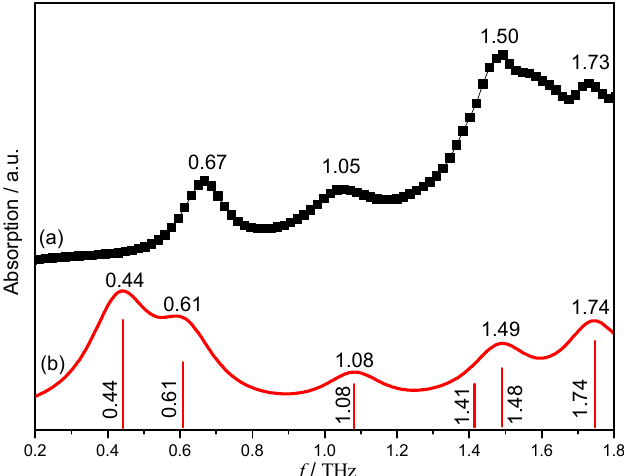
Figure 4. Experimental ( a ) and calculated ( b ) THz spectra of the hydrated co-crystal formed between NF and MELA.